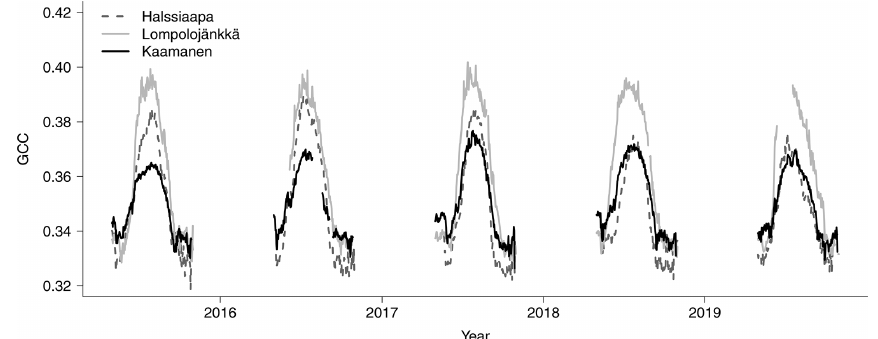
Figure 4. Daily camera-based GCC values from 1 May to 30 September in